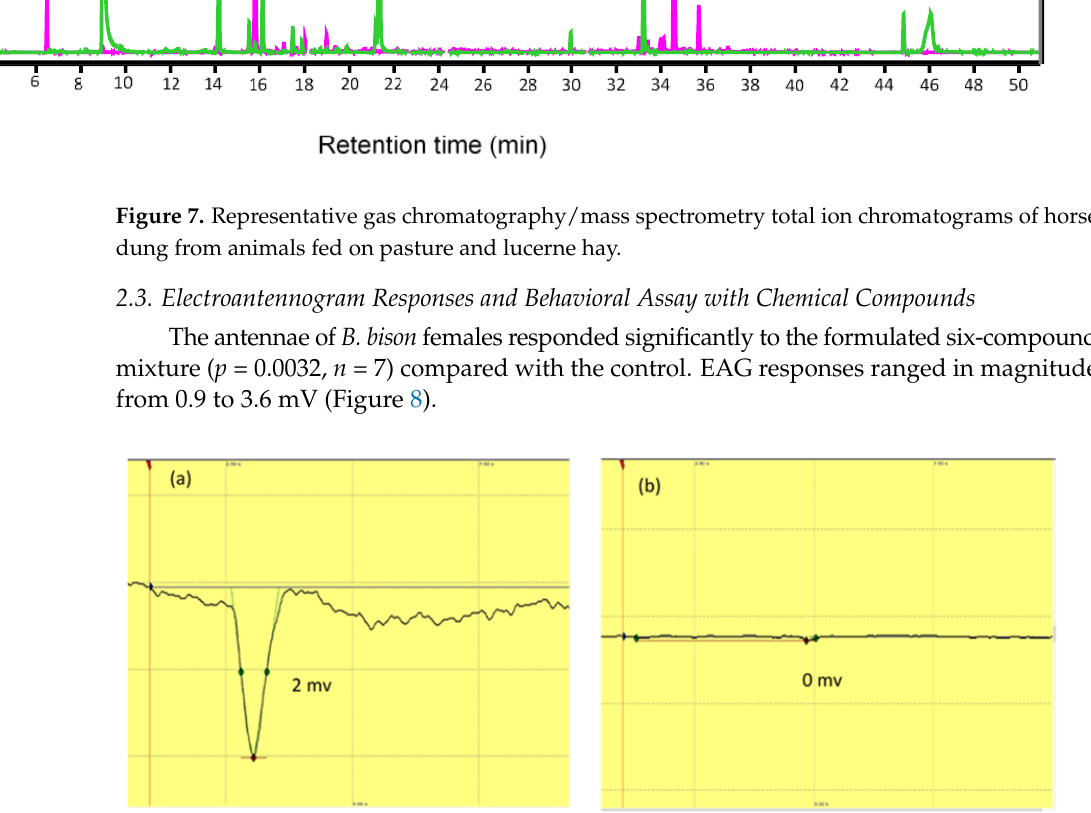
Figure 8. Representative EAG responses of female B. bison antennae to ( a ) six-compound mix (10 ppm) and ( b ) control. The stimulus was applied as a puff for 0.2 s using the SYNTEC stimulus controller ( n = 7 beetles).